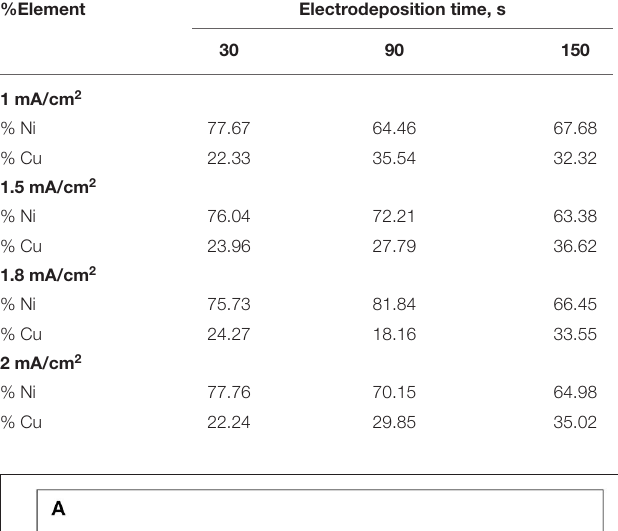
TABLE 3 | EDX analysis of porous Ni–Cu electrodeposited layers.